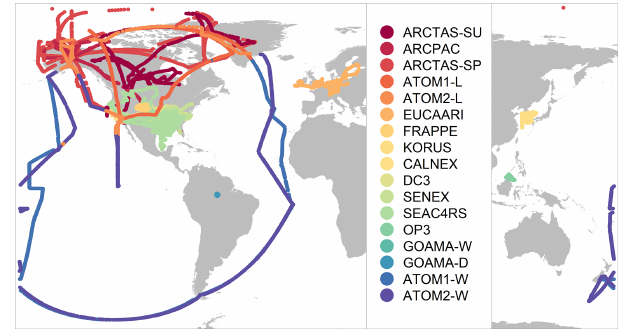
Figure 2. Location of flight tracks for the airborne field